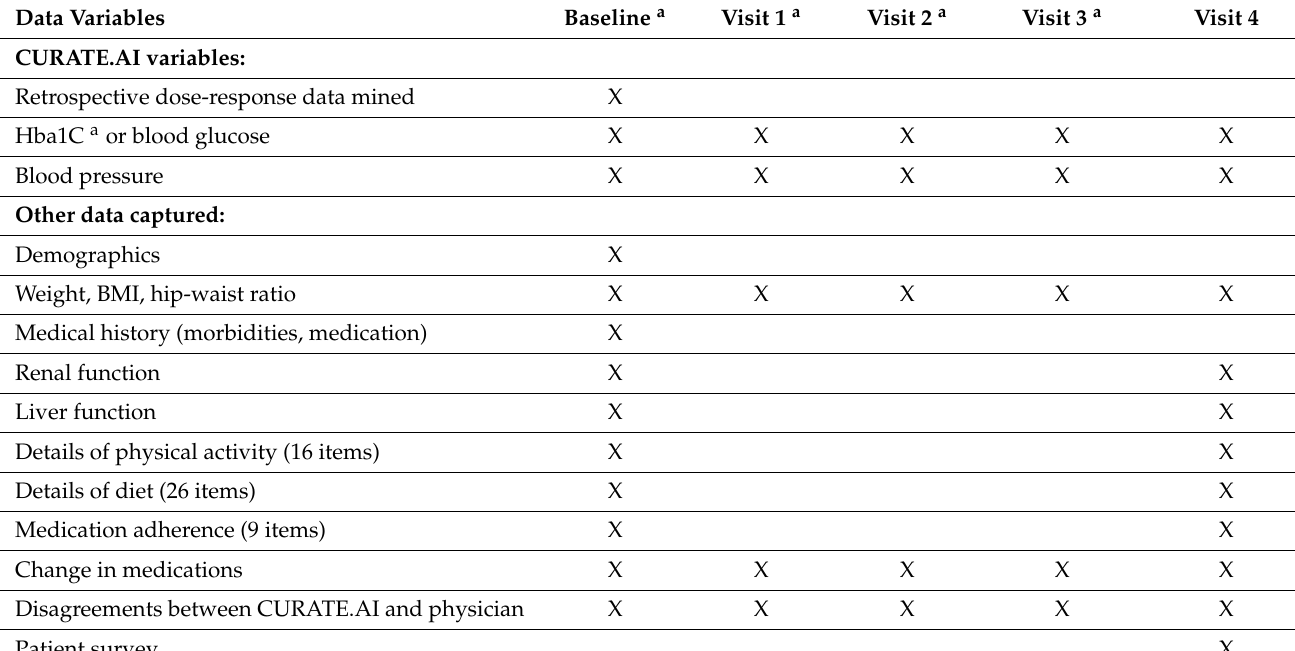
Figure 1. Patient flow. Table 1. Study procedures and timepoints .